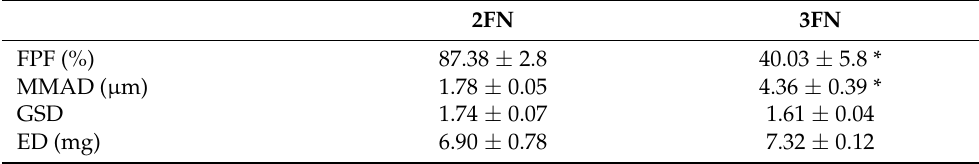
Figure 5. Next-generation impactor stage deposition profiles of 2FN and 3FN formulations. (Device = Dry Powder Inhaler, MPA = mouth-piece adaptor, MOC = micro-orifice collector). Data are reported as mean ± SD, n = 3, * p < 0.05. Table 3. Aerodynamic profiles of 2FN and 3FN as assessed by next-generation impactor (NGI). Fine particle fraction (FPF), median mass aerodynamic diameter (MMAD), geometric standard deviation (GSD) an emitted dose (ED) were determined from resulting NGI data (Unpaired Student t-test, Mean ± SD, n = 3, * p < 0.05).